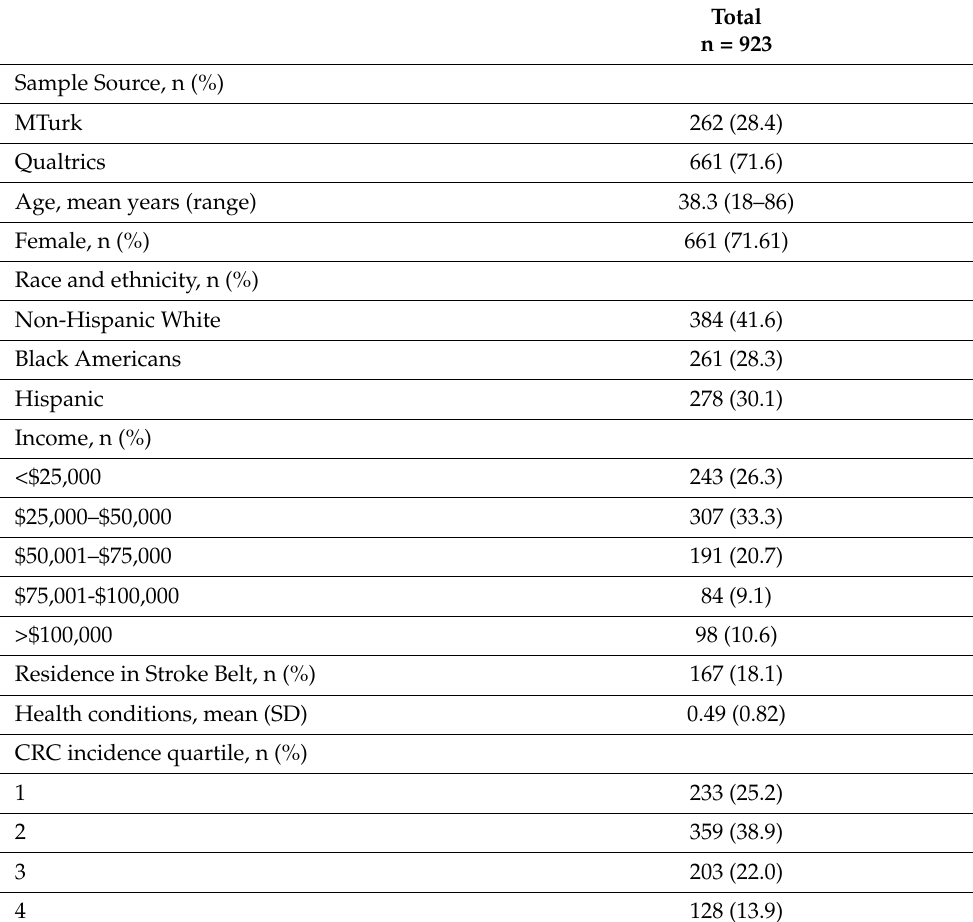
Table 1. Participant demographics and characteristics. Note: colorectal cancer is abbreviated in this and all other tables as “CRC”.